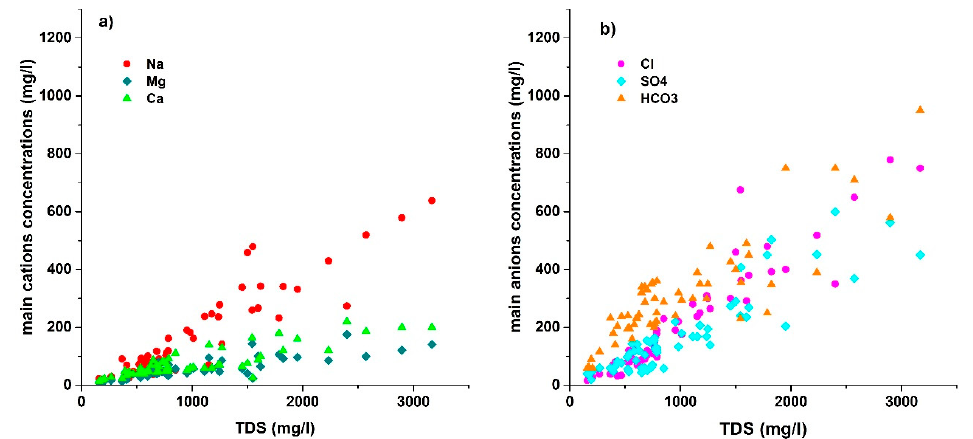
Figure 3. Scatter plot for ( a ) the main cations; ( b ) the main anions versus total dissolved solid (TDS). Table 3. Correlation coefficient matrix of major physiochemical parameters.